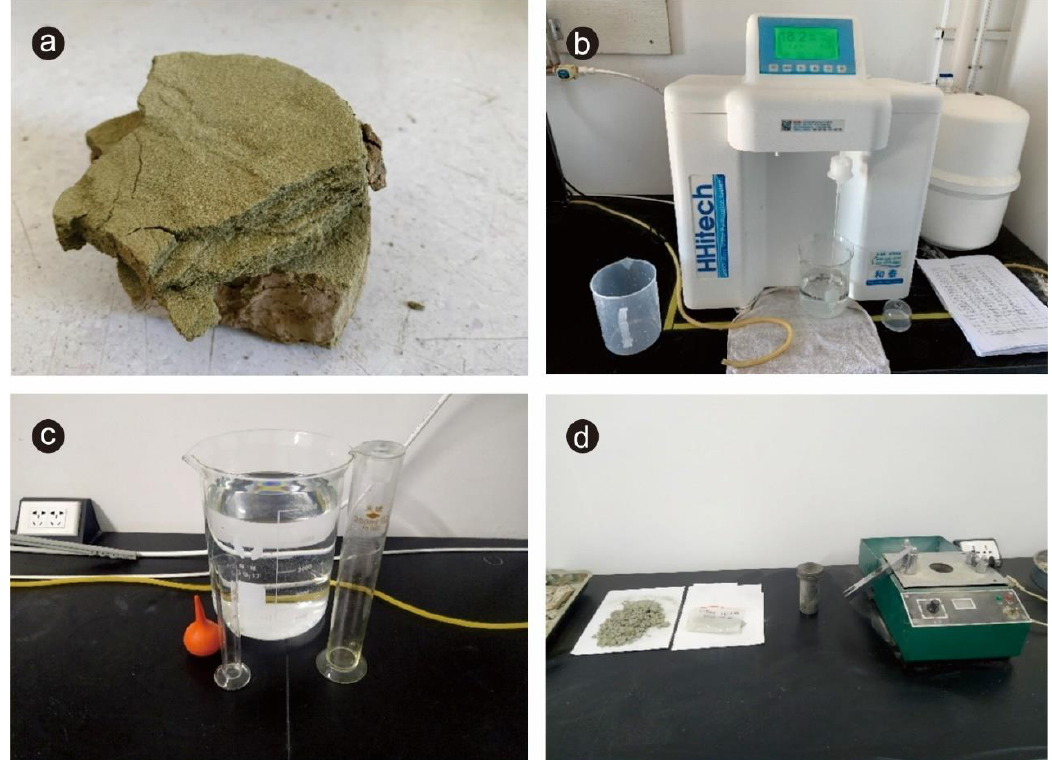
Figure 2. Water and rock sample preparation. ( a ) Weakly consolidated sandstone core with nearly horizontal layer formation; ( b ) p reparation of distilled water with resistivity value of 18.2 MΩ·cm; horizontal layer formation; ( b ) preparation of distilled water with resistivity value of 18.2 M Ω · cm; ( c ) preparation of 2% hydrofluoric acid; ( d ) sandstone cores ground and screened with a 50-mesh ( c ) preparation of 2% hydrofluoric acid; ( d ) sandstone cores ground and screened with a 50-mesh sieve.